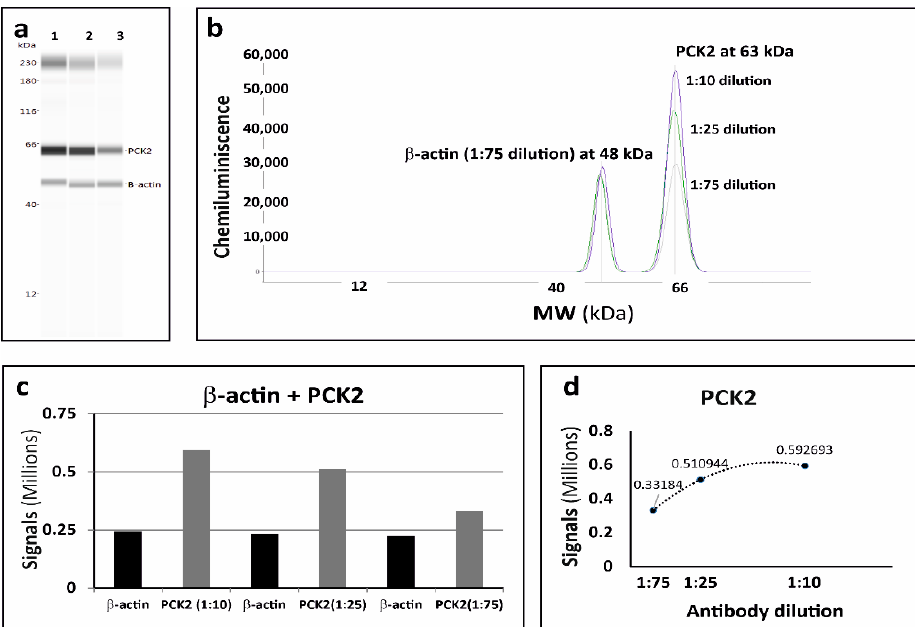
Figure 5. Multiplexing results of anti-PCK2 with anti- β -actin on capillary western blot. Three different dilutions of anti-PCK2 (1:10; 1:25; 1:75) were used with a fixed dilution of anti- β -actin (1:75) on a 0.5 mm 2 LCM section of rat kidney tissue, with a thickness of 10 µ m. ( a ) Gel-like image representation of cap-IA signals. Lane 1: anti-PCK2 dilution 1:10, lane 2: anti-PCK2 dilution 1:25, lane 3: anti-PCK2 dilution 1:75. ( b ) Electropherograms representation of cap-IA signals. ( c , d ) Data analysis of the area under the curve to understand the best dilution of anti-PCK2 for multiplexing.